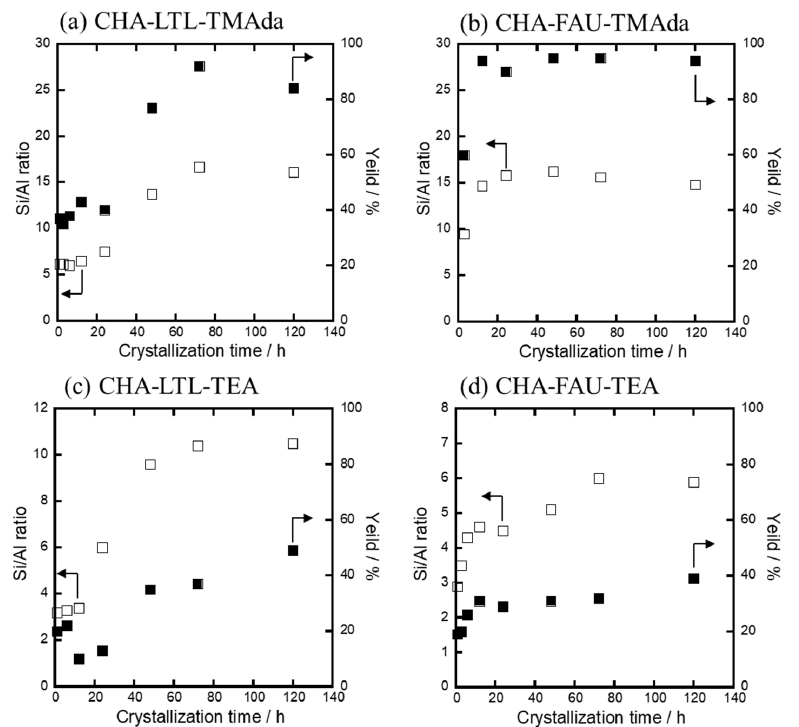
Figure 4. Relationship between crystallization time and yield ( ■ ) and Si/Al ratio ( □ ). ( a ) CHA–LTL–TMAda, ( b ) CHA–FAU–TMAda, ( c ) CHA–LTL–TEA, ( d ) CHA–FAU–TEA.